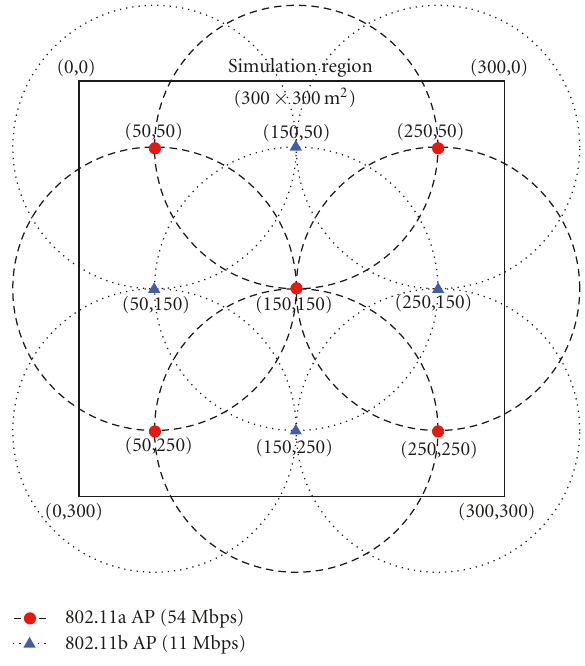
Figure 12: Simulation environment.